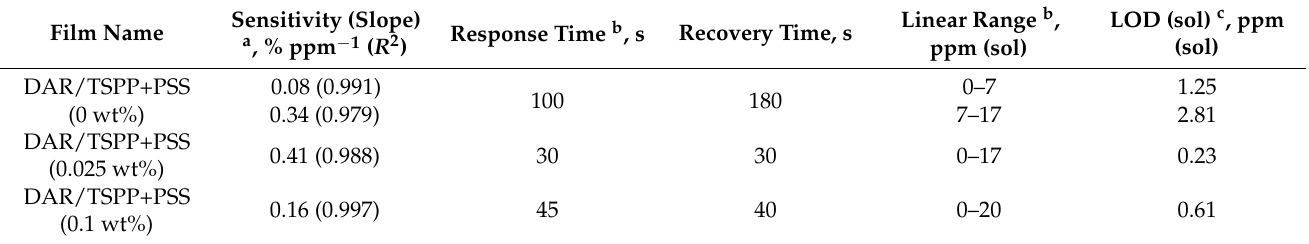
Table 1. Sensing parameters of the DAR/TSPP+PSS films with a different PSS